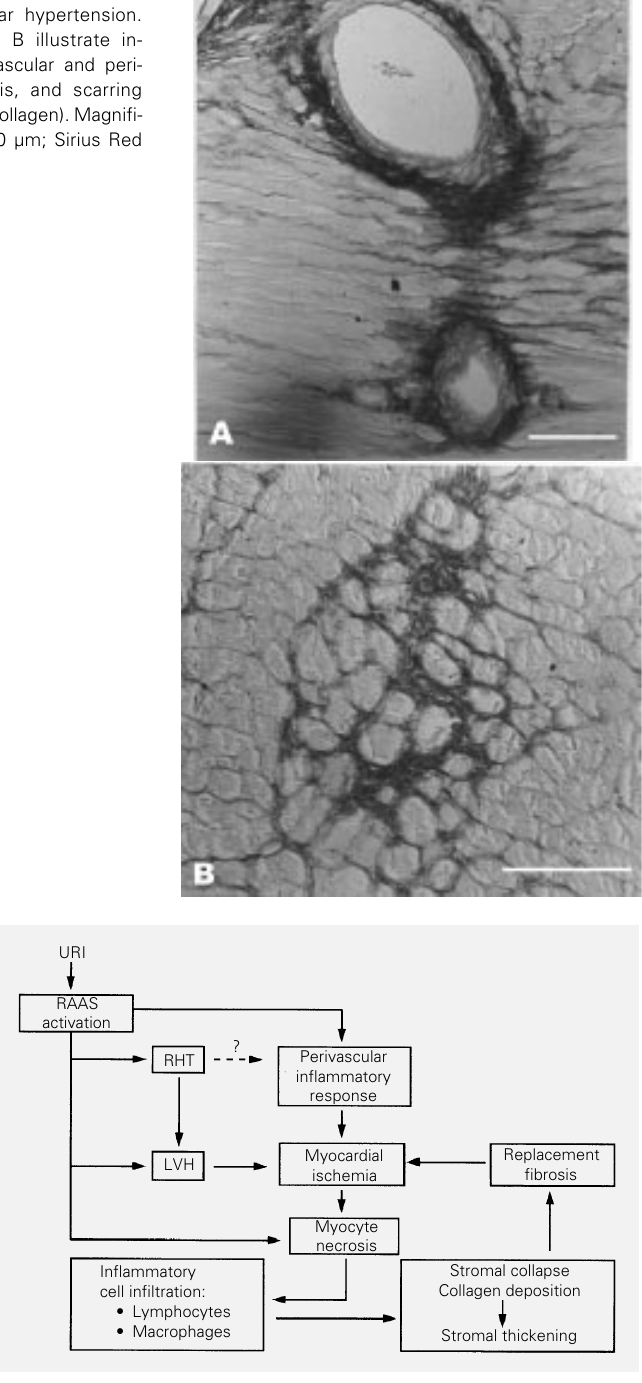
Figure 4 - Diagrammatic representation of a hypothesis for the physiopathol- ogy of myocardial fibrosis in renovascular hypertension. URI, Unilateral renal ischemia; RAAS, renin-angiotensin-aldosterone system; RHT, renovascular hypertension; LVH, left ventricular